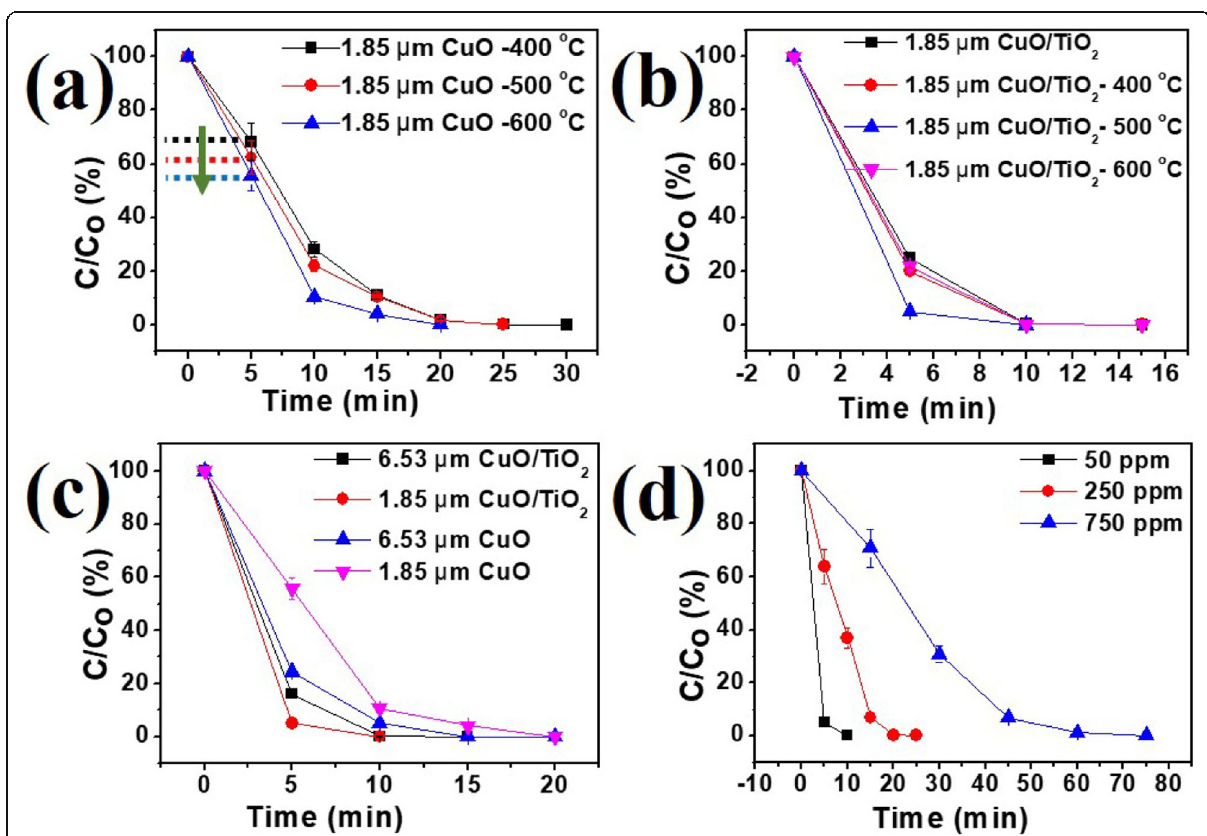
Fig. 5 Degradation results of a CuO NRs samples annealed at different temperatures. b CuO/TiO 2 samples annealed at different temperatures. c Samples at different lengths of CuO NRs with and without capping of the TiO 2 layer. d Different initial concentrations of RhB with the most active sample (600 °C 1.85 μ m CuO NRs + 500 °C TiO 2